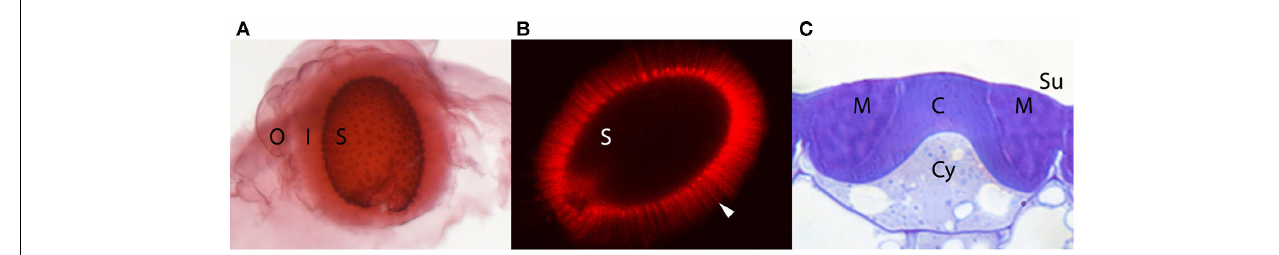
including the more densely stained “rays” (arrowhead) extending outward from the top of each columella can be seen. (C) Cross section of a single seed coat epidermal cell on the outer surface (Su) of a seed at 11days post anthesis stained with toluidine blue O.The mucilage (M) between the columella (C) and the outer primary wall can be seen. At this stage cellulose for the columella is still being synthesized and will continue until the cytoplasm (Cy) is completely